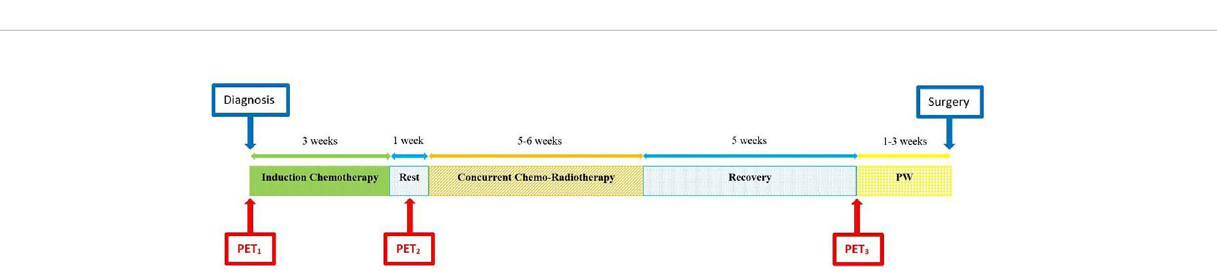
FIGURE 2 | Diagram of total neoadjuvant protocol from diagnosis to surgery, including induction chemotherapy and concomitant chemo-radiotherapy, with 18 F-FDG PET/CTs at relative time points. PW, preoperative workup, including